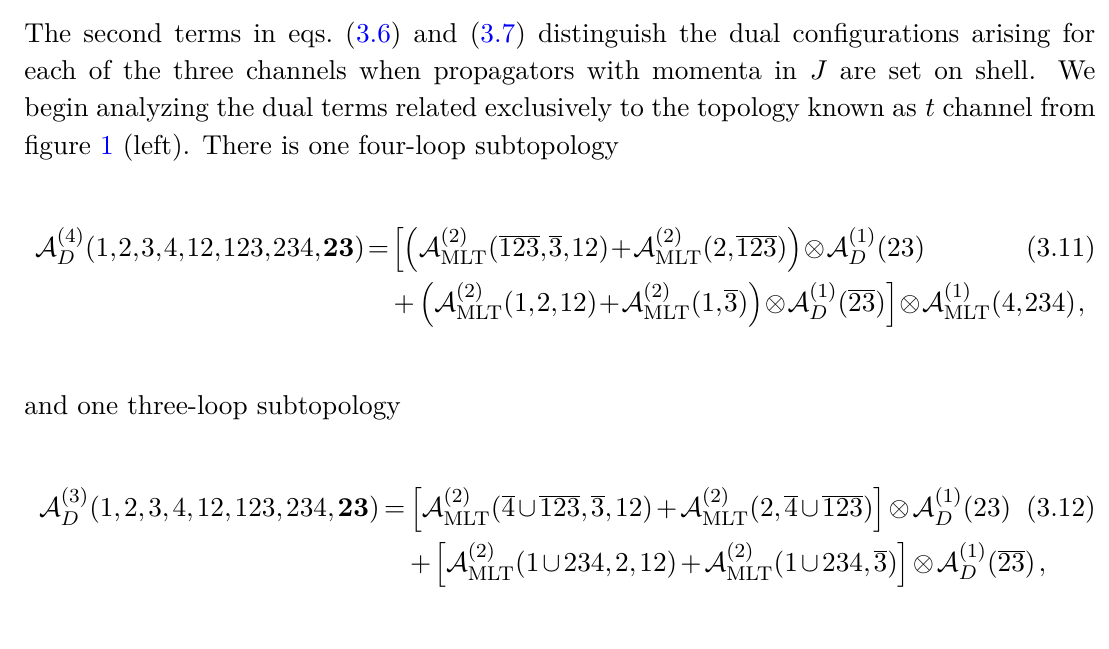
Figure 4 . Diagrammatic representation of the three-loop subtopology A (3) 123 , 12 , J ) . The dashed lines and bold labels indicate that propagators in the J -sets are set on shell in either of the two momentum